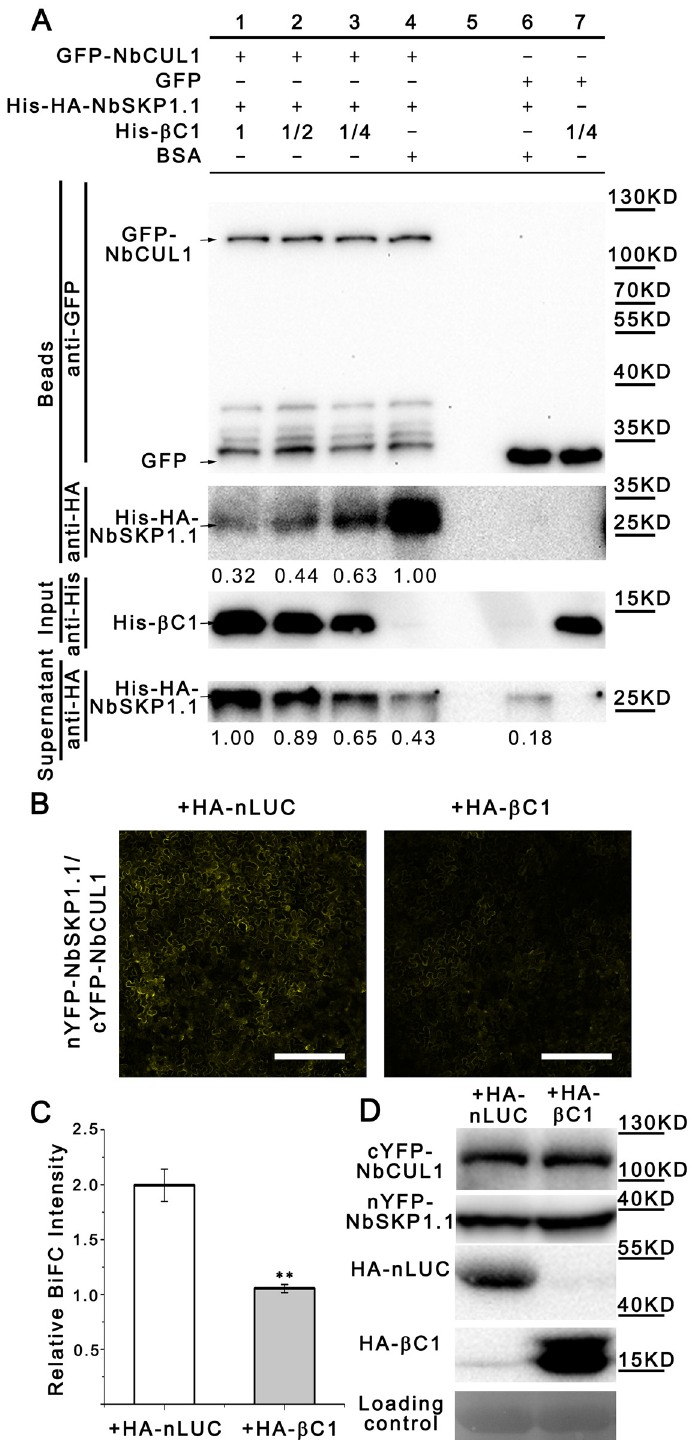
Fig 3. CLCuMuB β C1 interferes with the interaction between NbCUL1 and NbSKP1.1 in vitro and in vivo . (A) GFP competitive pull-down assay in vitro . His- β C1 was expressed in E . coli as inclusion body and refolded through urea-arginine dialysis. BSA (NEB, USA) was used as a control. GFP-NbCUL1 or GFP was expressed in N . benthamiana leaves and trapped through GFP-Trap agarose. After the supernatant was discarded, GFP-Trap agarose was incubated with E . coli -expressed His-HA-NbSKP1.1, then the